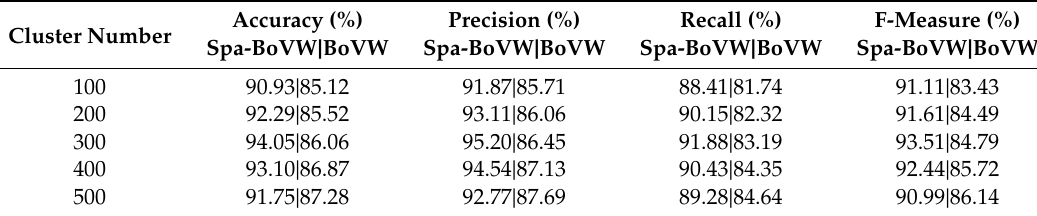
Table 7. Performance of Spa-BoVW vs. BoVW in detecting gambling